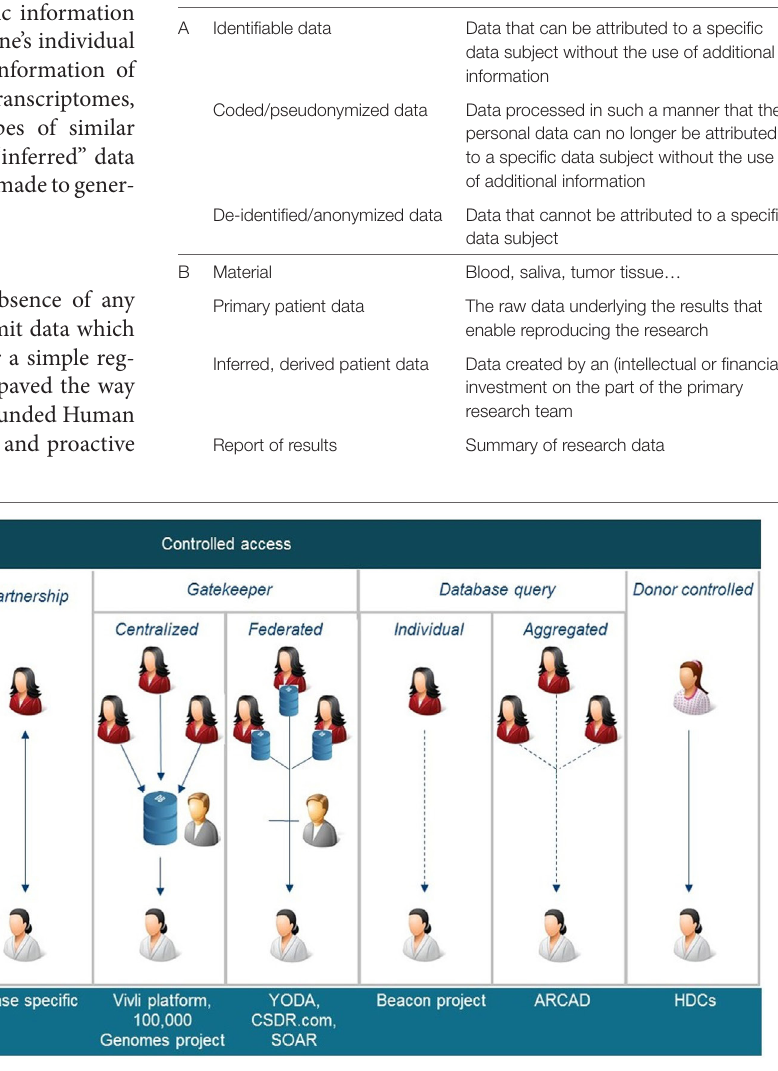
FigUre 2 | Schematic overviews of nine different data sharing models identified. PDS, project data sphere, PGP, Personal Genome Project, EGA European Genome-phenome Archive, YODA Yale University Open Data Access, CSDR.com ClinicalStudyDataRequest.com, SOAR, Supporting Open Access Research, ARCAD Aide et Recherche en Cancérologie Diggestive, HDC health data cooperatives. Some of these models are also applicable to share